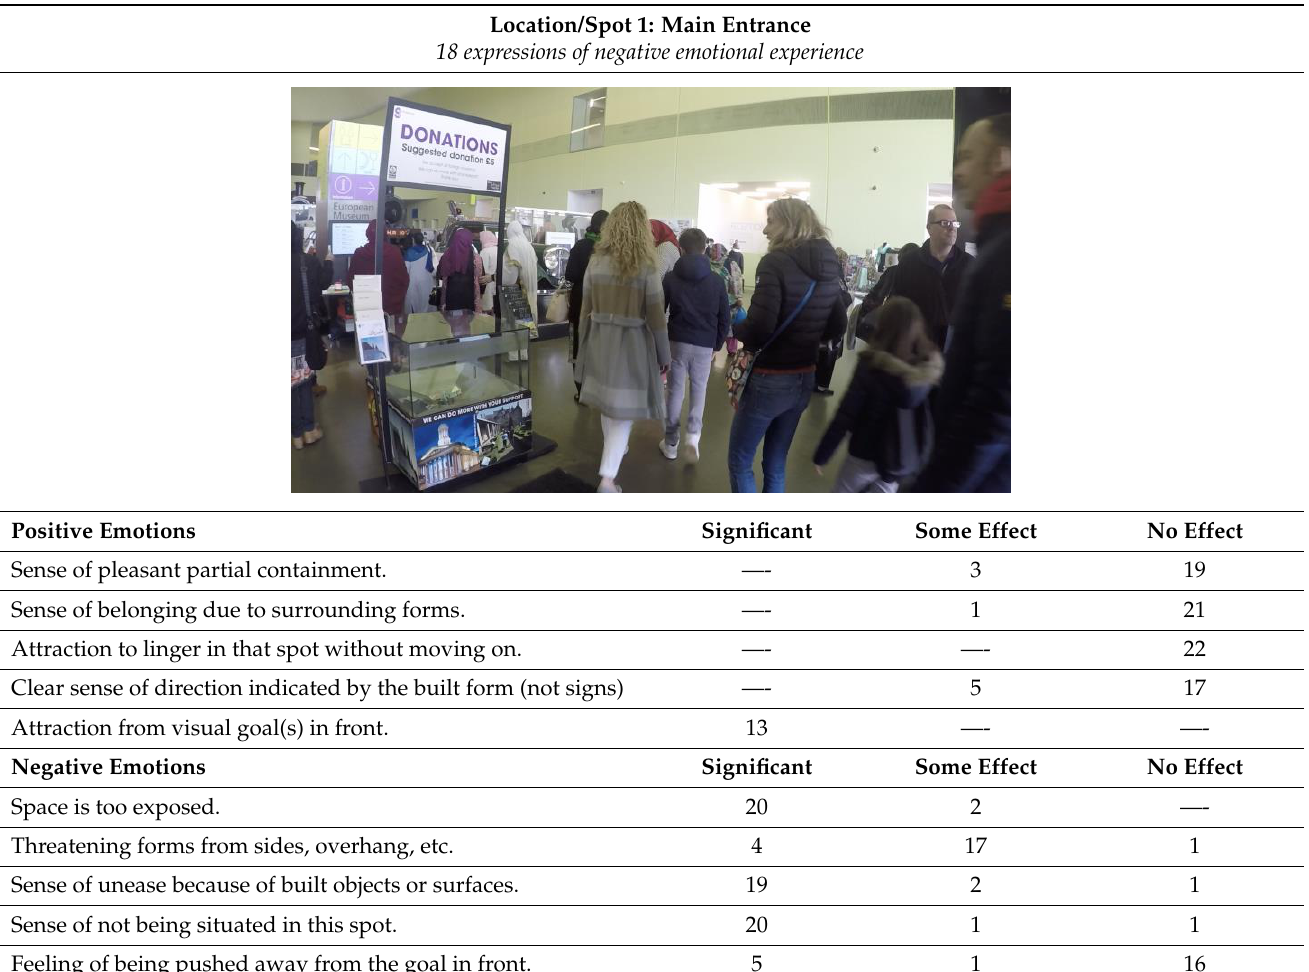
Table 7. Examples of two locations at the Riverside Museum and the emotional experience each offers to the users. (Photos by A. Salama).